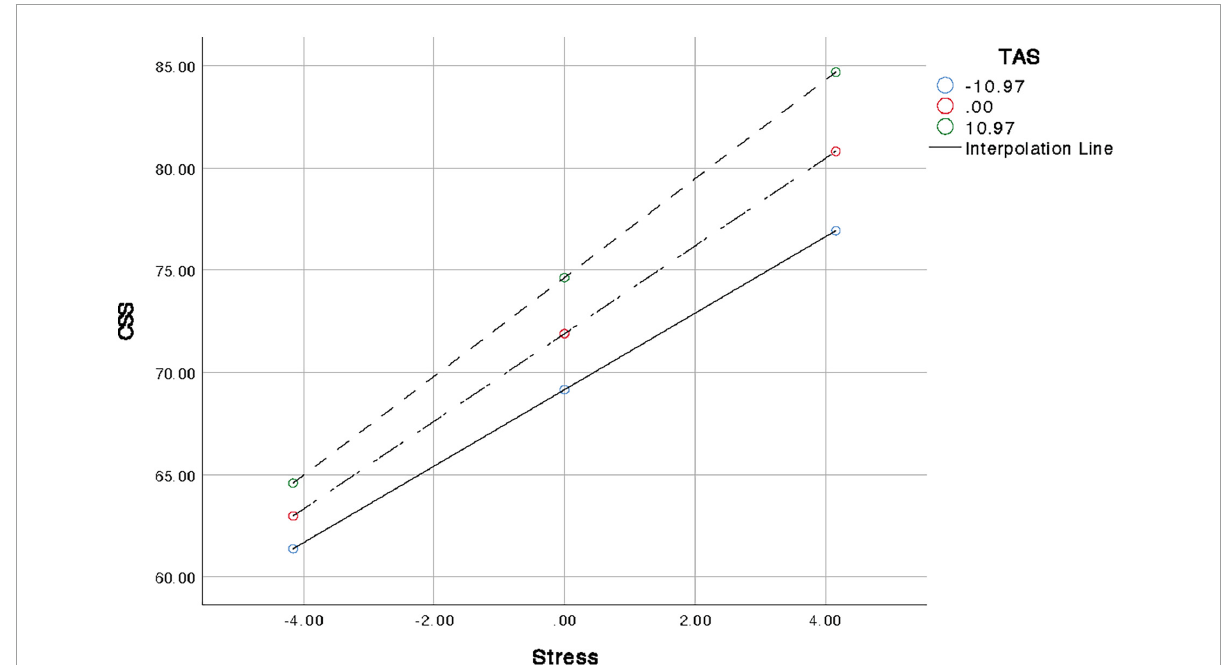
FIGURE1 Graphical presentation of moderating role of alexithymia between stress and